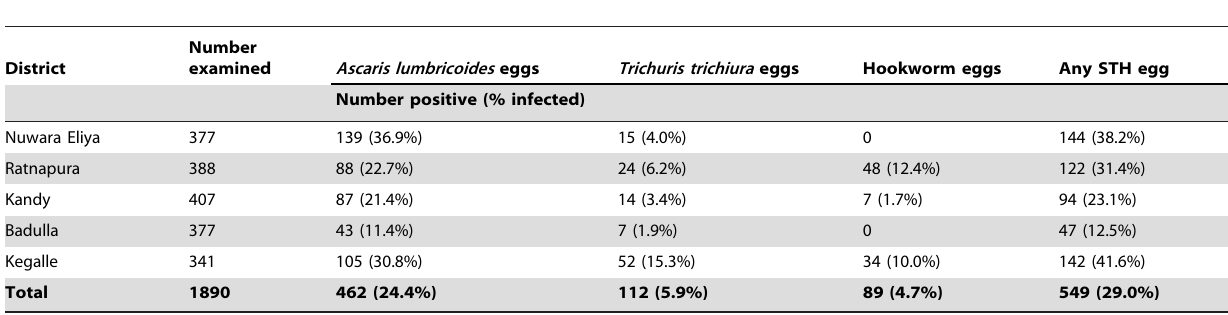
Table 1. Prevalence of soil-transmitted helminth infections in plantation sector school children by district.